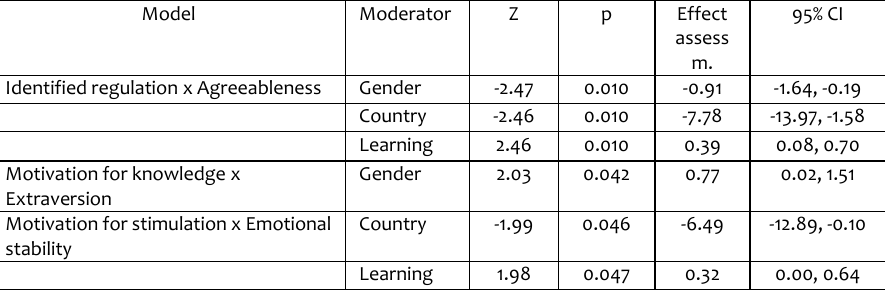
Table 3. Moderation